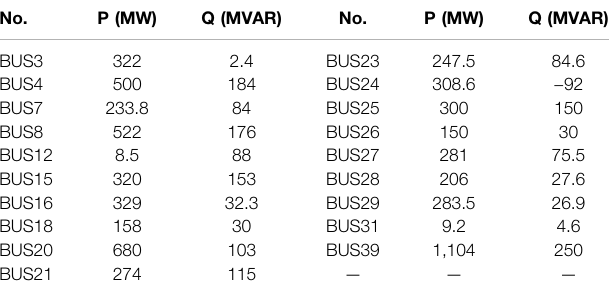
TABLE 3 | The active and reactive power of each load node at the load level of 100%.